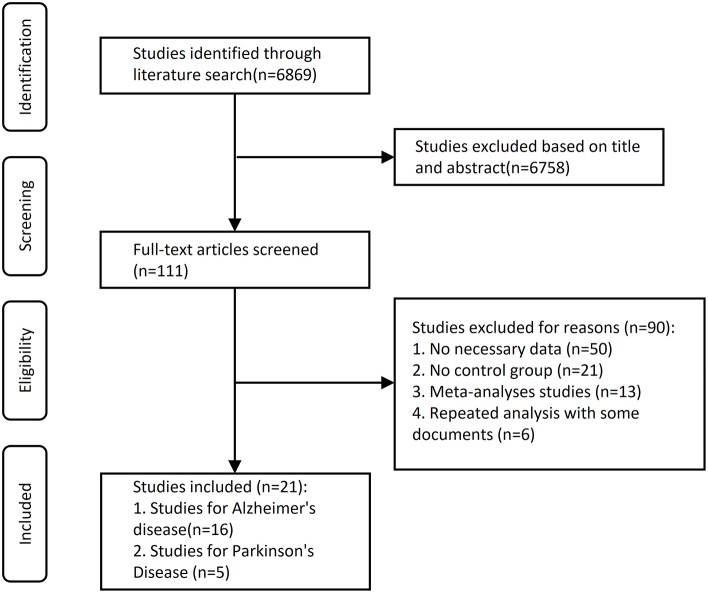
Flowchart describing the approach used to identify eligible studies. We conducted a systematic search on Medline (via PubMed and Web of Science) and covering all articles up until June 1, 2019.